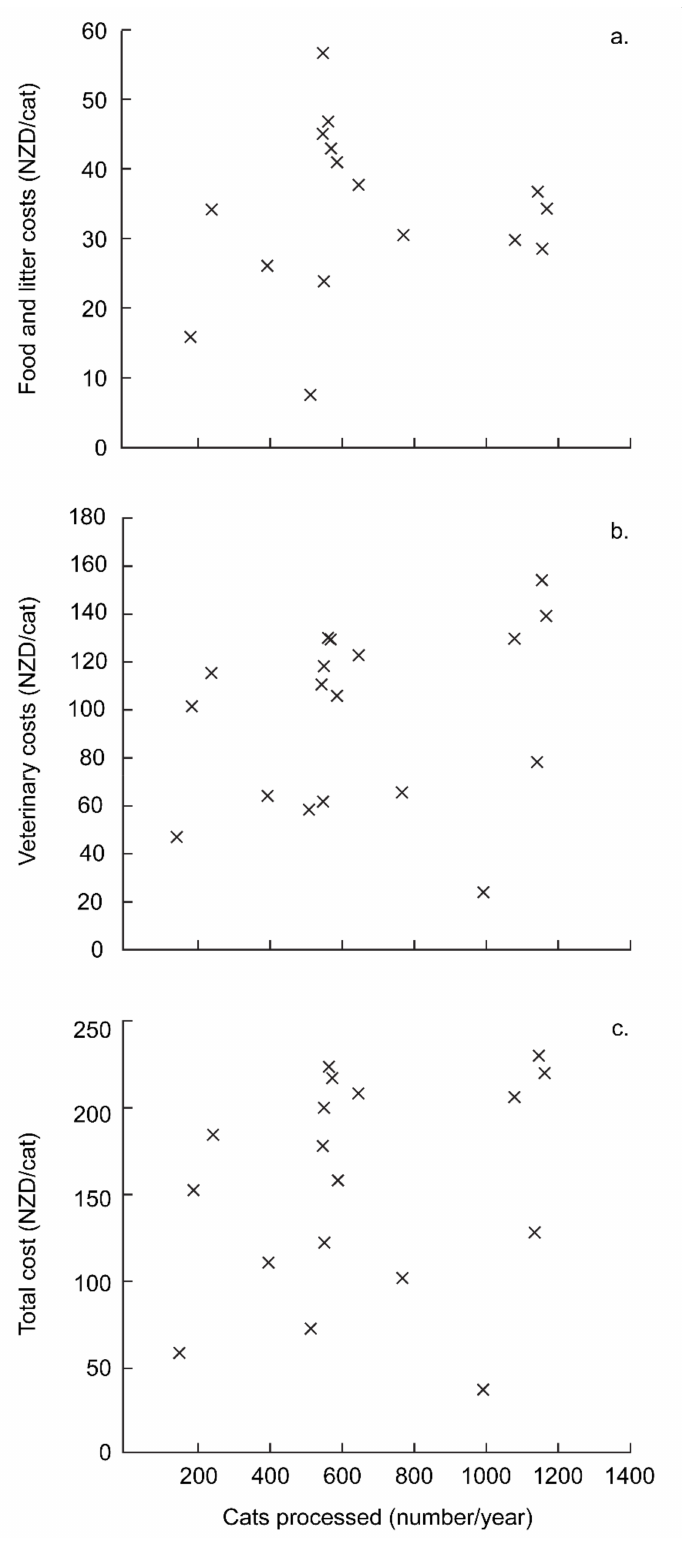
Figure 7. Per capita costs in relation to the number of cats processed for trap–assess–resolve (TAR) through Lonely Miaow, Auckland, New Zealand. Each point represents a year, from 1999–2017. ( a ) gives food and litter costs, ( b ) gives veterinary costs and ( c ) gives total costs. All costs are in